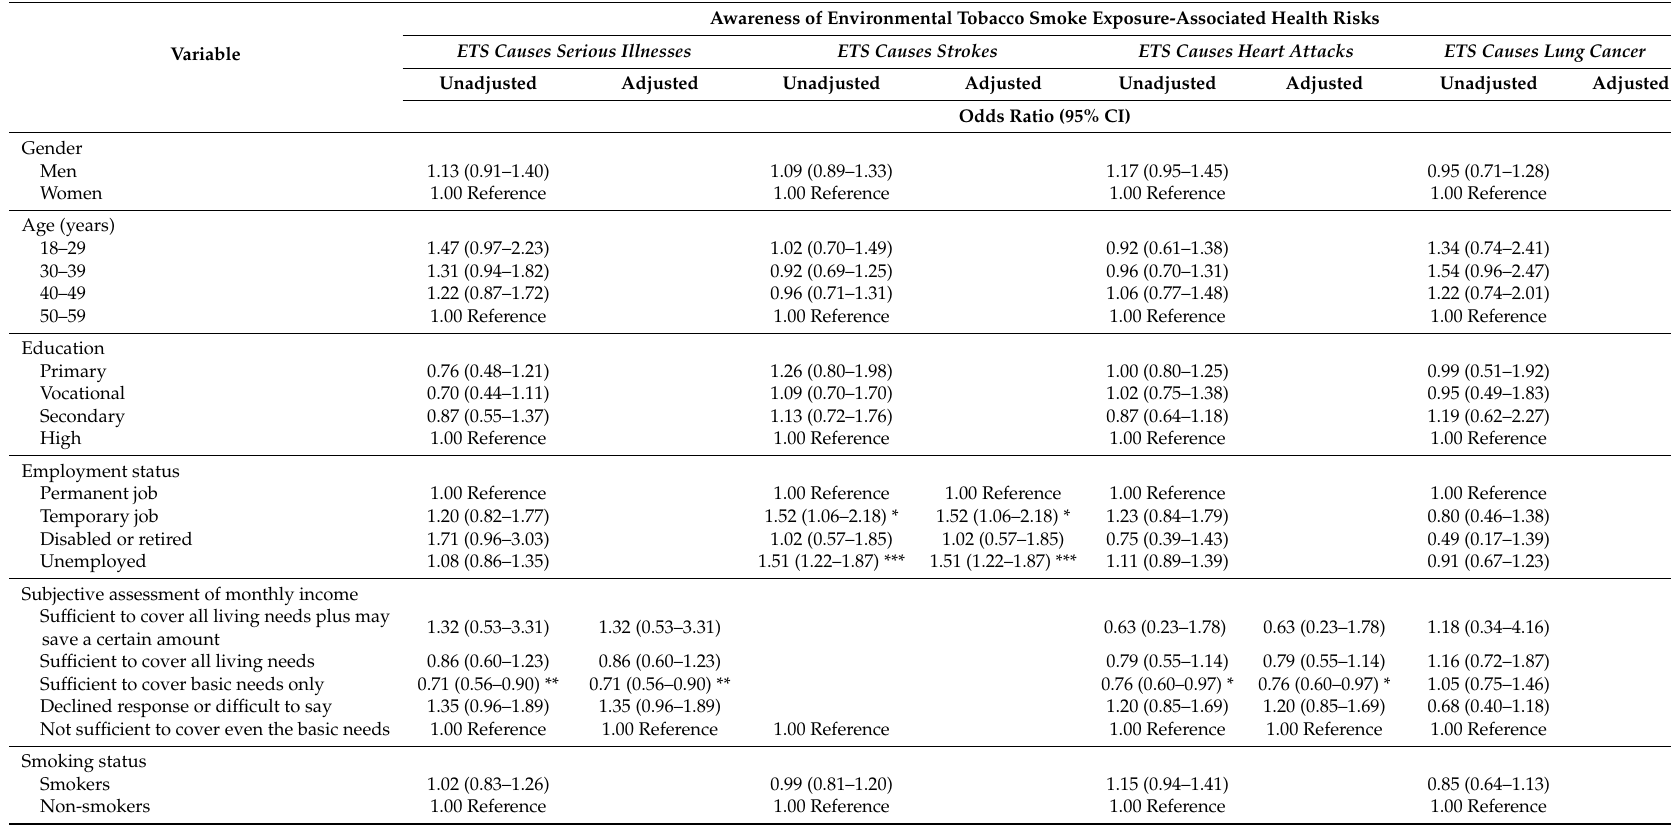
Table 2. Lack of awareness of environmental tobacco smoke exposure-associated health risks among the study respondents n =